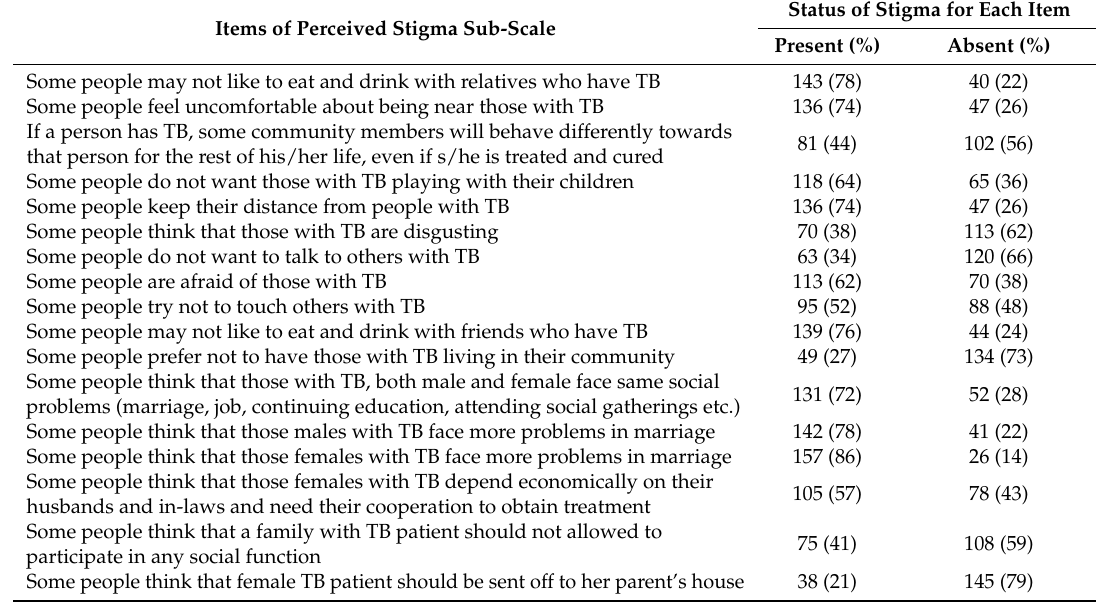
Table 2. Level of perceived stigma associated with tuberculosis.